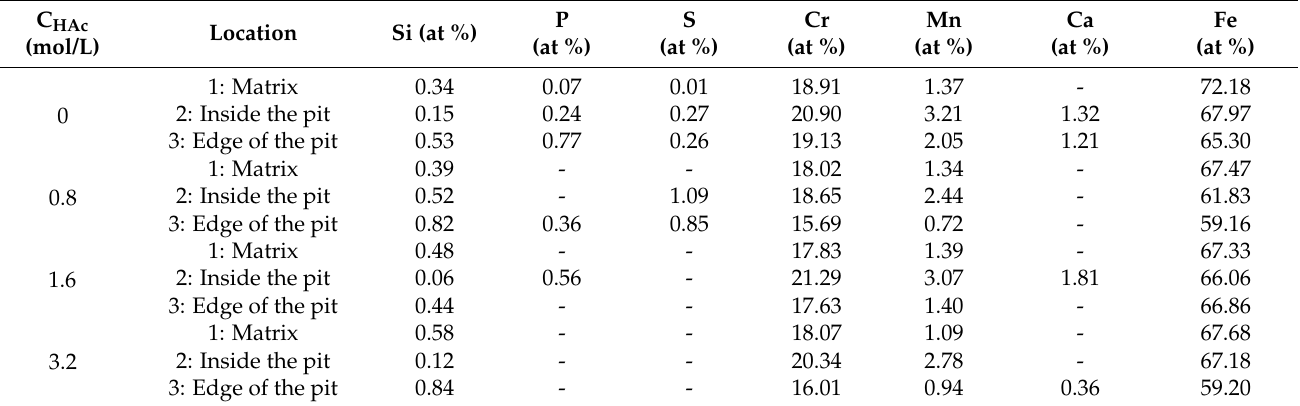
Table 2. EDS results of the metastable pits of 304 SS in 0.6 mol/L NaCl solutions with HAc.